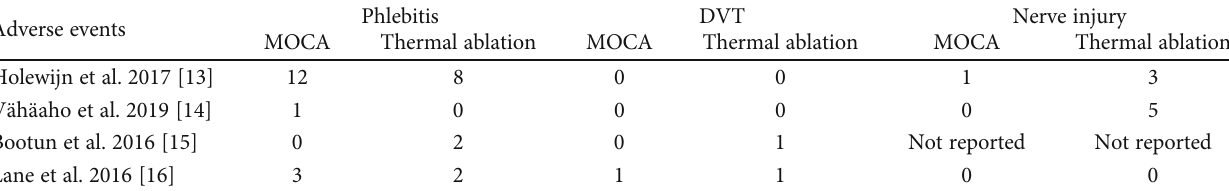
Table 5: Adverse events in the included